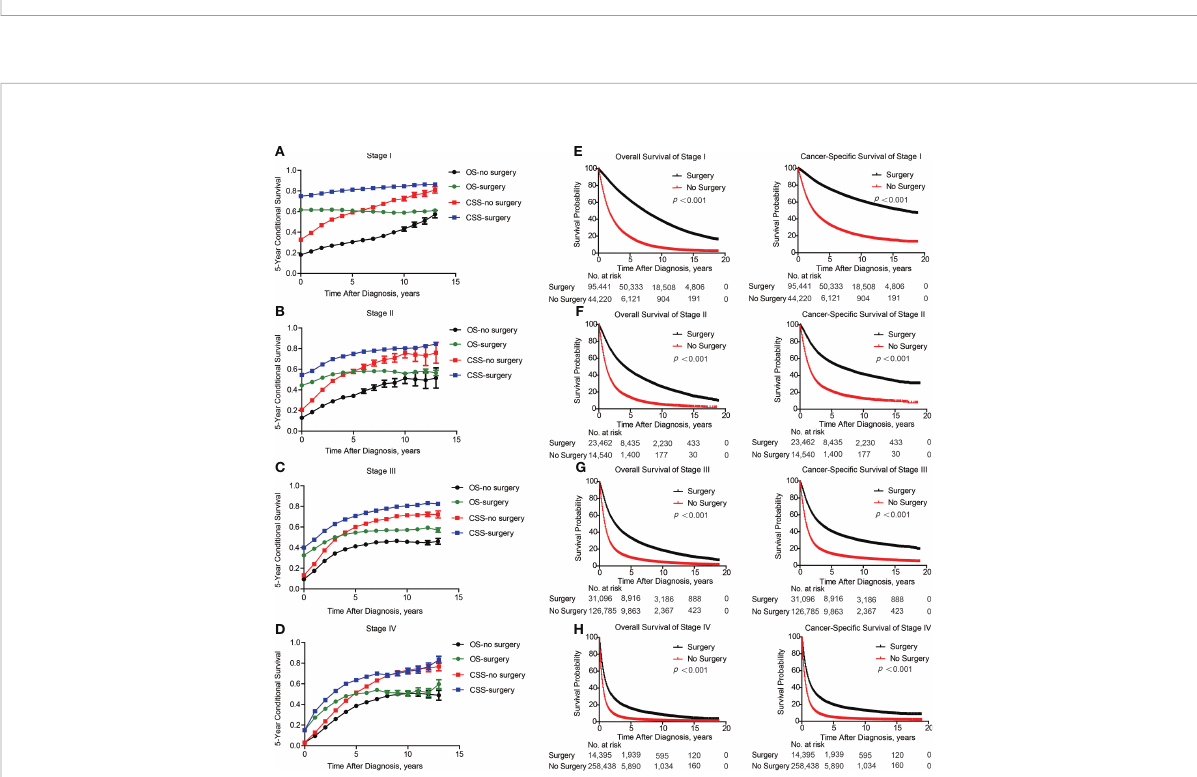
FIGURE 4 Subgroup analyses of survival based on surgical treatment in lung cancer patients with Different stages. Subgroup analyses of 5-year conditional survival rate based on surgical treatment or not of patients in stage I (A) , stage II (B) , stage III (C) and stage IV (D) . Subgroup analyses of overall and cancer-speci fi c survival with Kaplan-Meier analysis based on surgical treatment or not of patients in stage I (E) , stage II (F) , stage III (G) and stage IV (H)